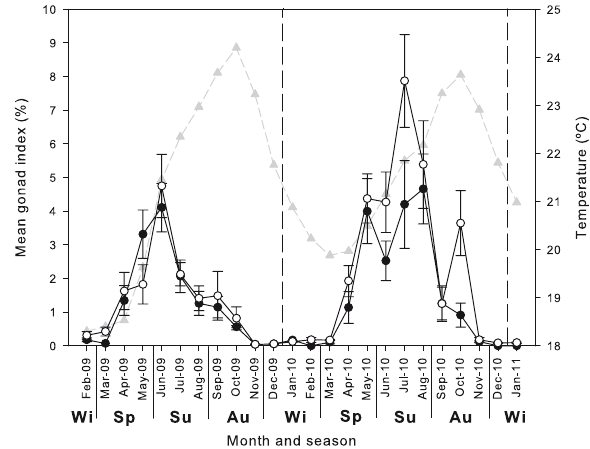
Fig . 3. – Mean monthly gonad index of males and females of H. sanctori at Gran Canaria and mean sea water temperature through time. The seasons are represented as: Wi, Winter; Sp, Spring; Su, Summer; and Au, Autumn. Males: full circles. Females: empty cir- cles. Temperature: grey triangles. The error bars are the standard error of means. Mean GI from Feb-2009 to Jan-2010 were pooled from three sites, while mean GI from Feb-2010 to Jan-2011 were pooled from two